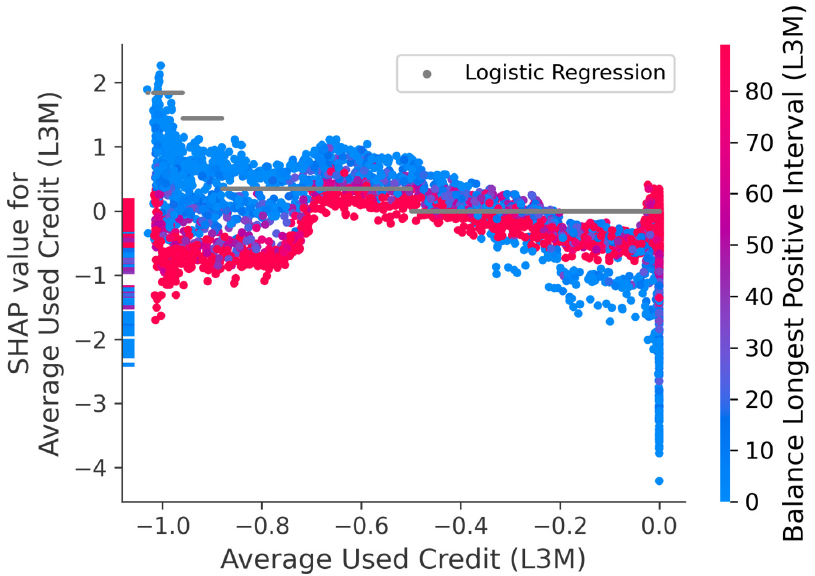
Figure 11. SHAP dependence plot showing SHAP values for Average Used Credit (L3M) , color-coded based on the value of the Balance Longest Positive Interval (L3M) feature. Logistic Regression feature effects for average used credit is displayed in grey and scaled to log-odds, corresponding to the SHAP values on the y -axis. All values from the four separate Average Used Credit bins are mapped back to original values to fit the x -axis.